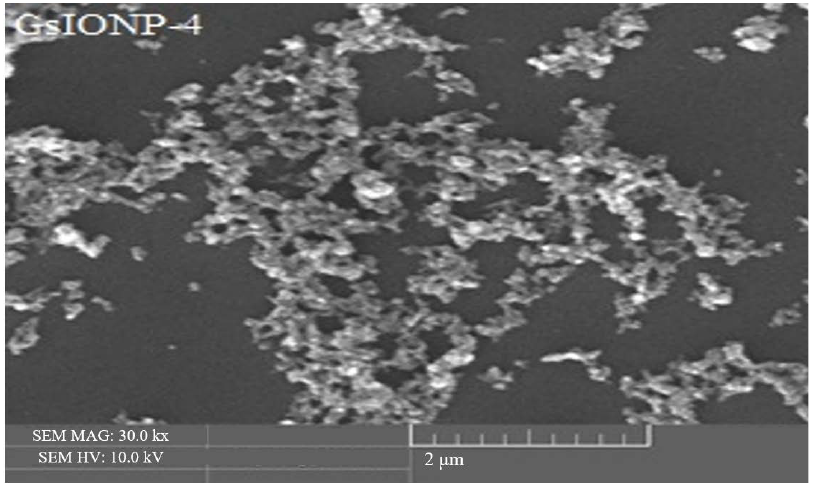
Figure 3. SEM images of nanoparticles synthesis GS-IONPs, (GS extract mixing with ferrous chloride at pH of 3.8 and volume ratio of 2:1).